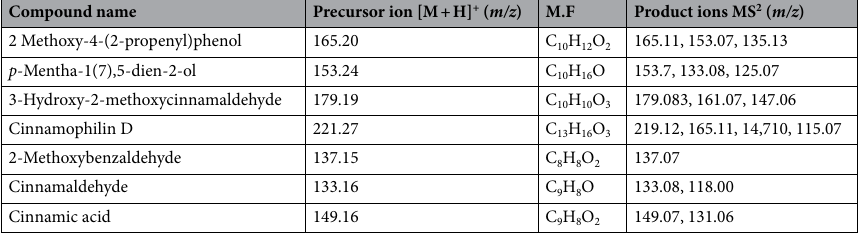
Table 1. Identified compounds from cinnamon